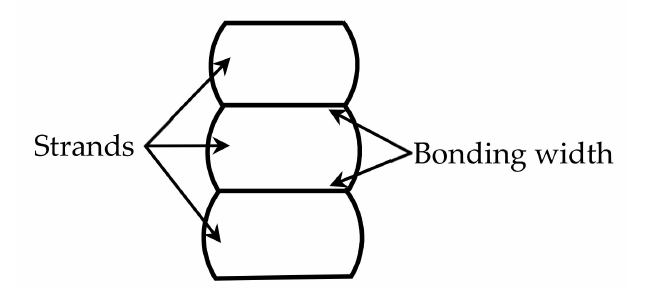
Figure 1. Stack of deposited strands for the formation of a 3D plastic structure (cross-sectional